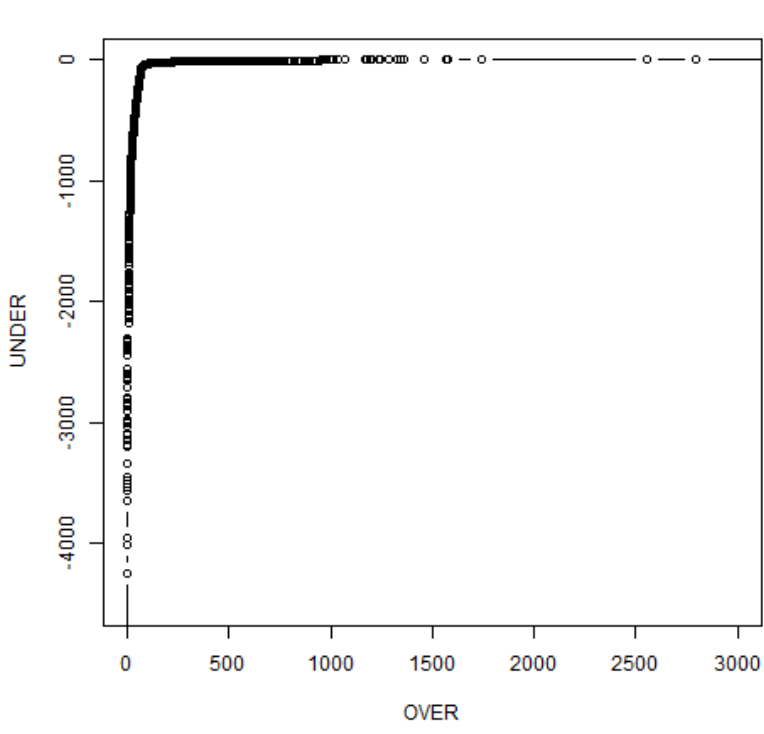
Figure 5. Regression receiver operator characteristic (RROC) curves for RF best model (test subset).